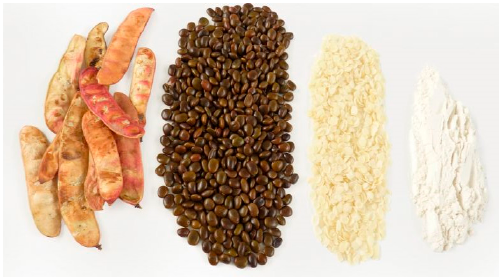
Figure 1. Caesalpinia spinosa gum, from the pod to the flour.